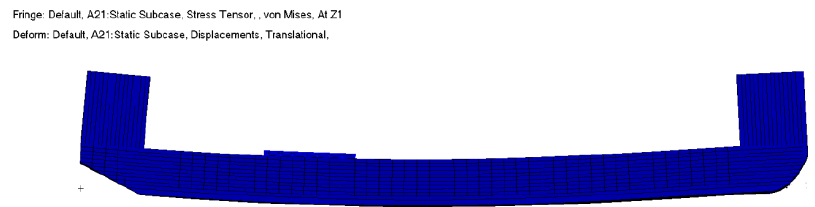
Figure 19. Deformation diagram of the hull structure when just sitting on the sand.